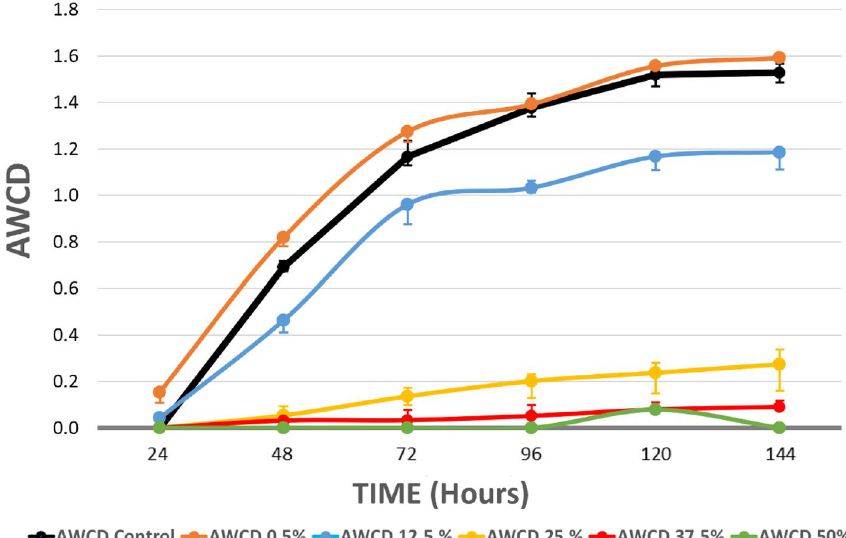
Figure 1. AWCD vs time curves of metabolized substrates in Biolog EcoPlates based on 144-h incubation of river microorganisms exposed to Satureja montana hydrolate. Black line is the negative control (microorganisms of water that have not been treated with hydrolate). Each point is the average value of three replicates. Error bars represent the standard deviation of mean of three replicates (n =